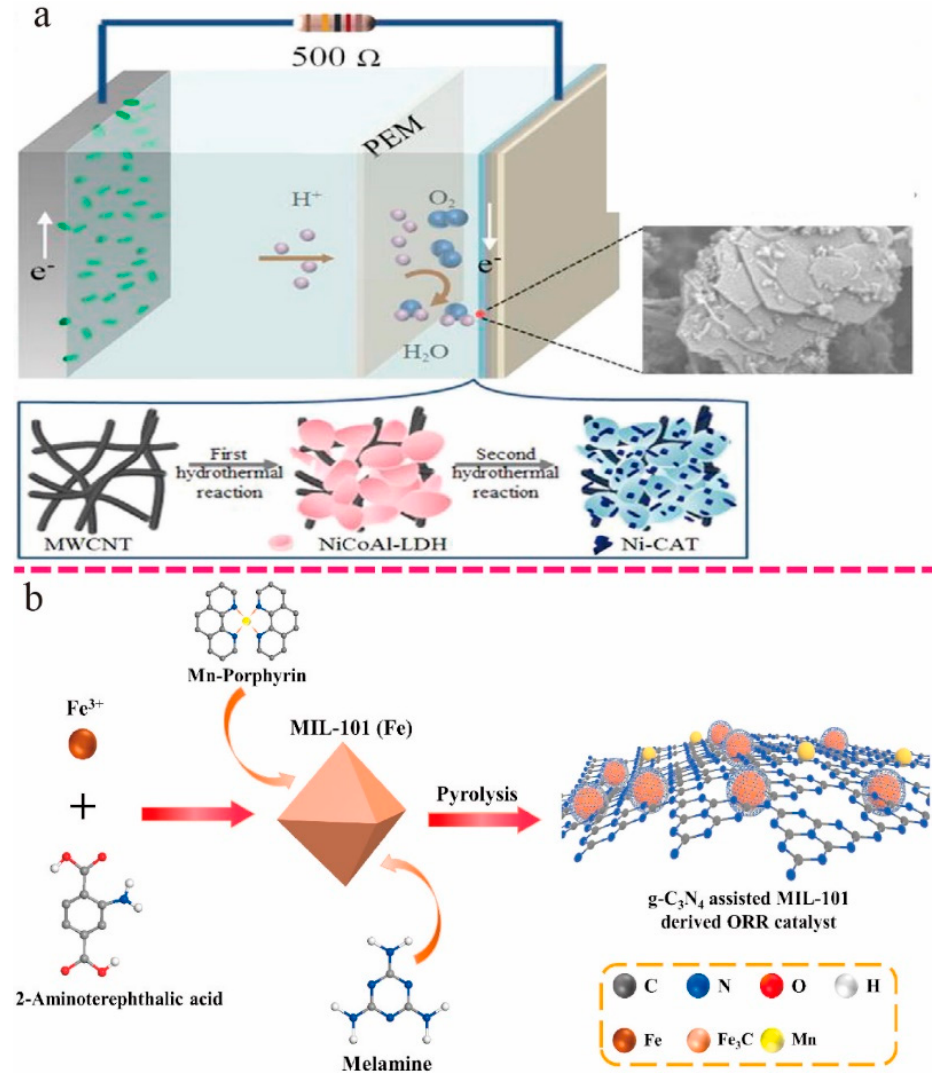
Figure 3. ( a ) Schematic of MFC and the preparation process of the Ni-CAT/NiCoAl-LDH/MWCNT composite [50]. Copyright 2021, Elsevier. ( b ) Schematic illustration of the fabrication of the Mn–Fe@g-C 3 N 4 electrocatalyst [49]. Copyright 2020, Elsevier.